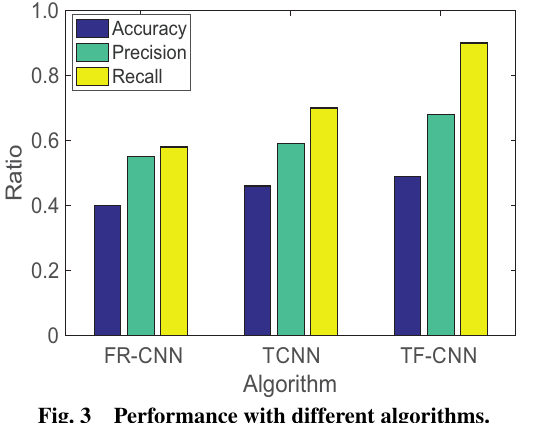
Fig. 3 Performance with different algorithms.